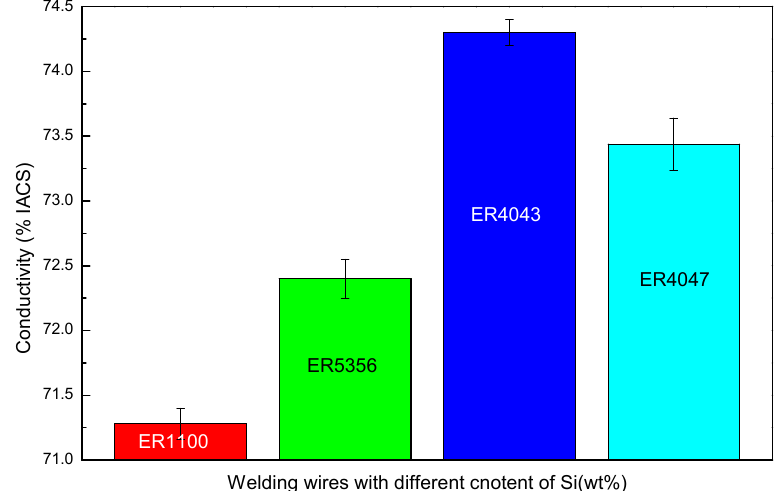
Figure 12. The change of conductivity of the butt joints with the increase in Si elements ( 𝐼 𝑚𝑎𝑖𝑛 = 60 A ).